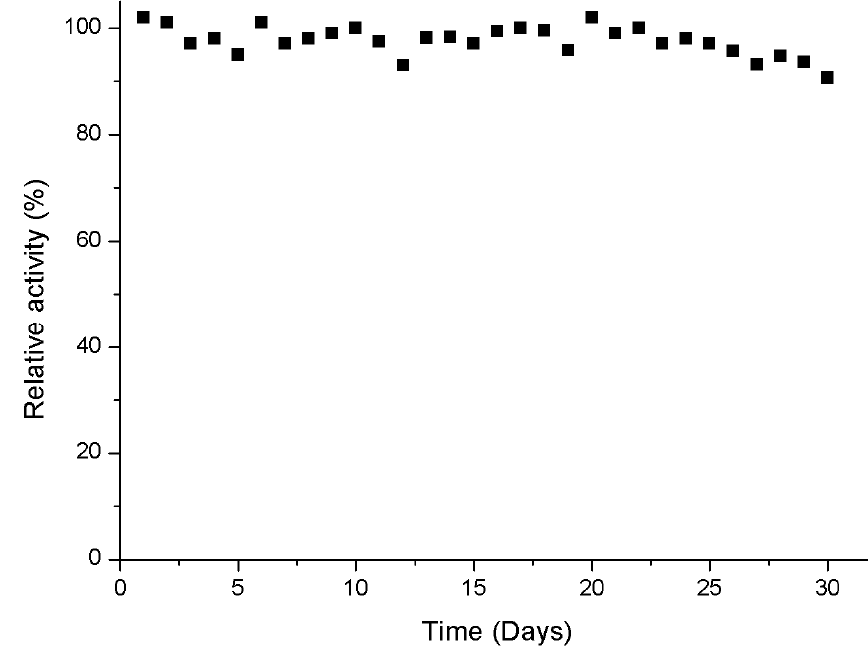
Figure 8. Operational catalytic stability of the immobilized invertase in the developed microfluidic reactor. The 5.0% ( w / v ) sucrose solution pH 4.5 was continuously fed during 30 days to the microchannel reactor at a flow rate of 8.0 µL·min − 1 . Trial was performed at a constant temperature of 50 °C. Experiments were performed in triplicates. Standard deviation did not exceed 5%.